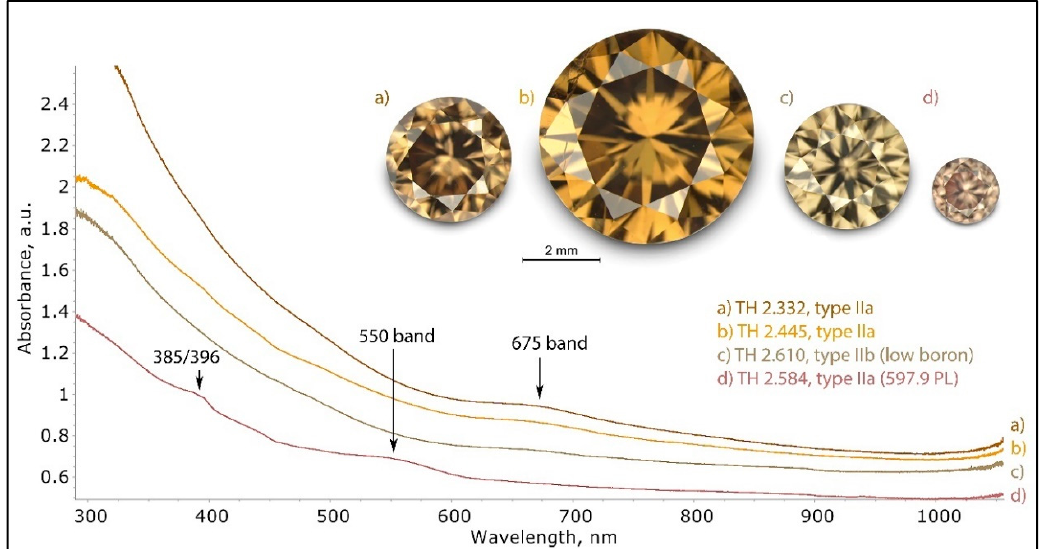
Figure 26. The different UV-Vis-NIR spectra of brown type II diamonds, recorded at 77 K. As with type I brown diamonds, the color of such stones is the result of the relatively flat and steadily increasing continuum from the NIR to UV. With nitrogen-related absorptions, such as N3 and H3, typically absent, the only features overlaying the continuum are a broad band at 675 nm, and for the very unusual samples with the 597.9 nm PL, a broad band at 550 nm and a double band at 385/396 nm can be seen, which is basically a regular UV-Vis-NIR spectrum for any pink brown type IIa diamond. The spectra were shifted vertically for clarity.